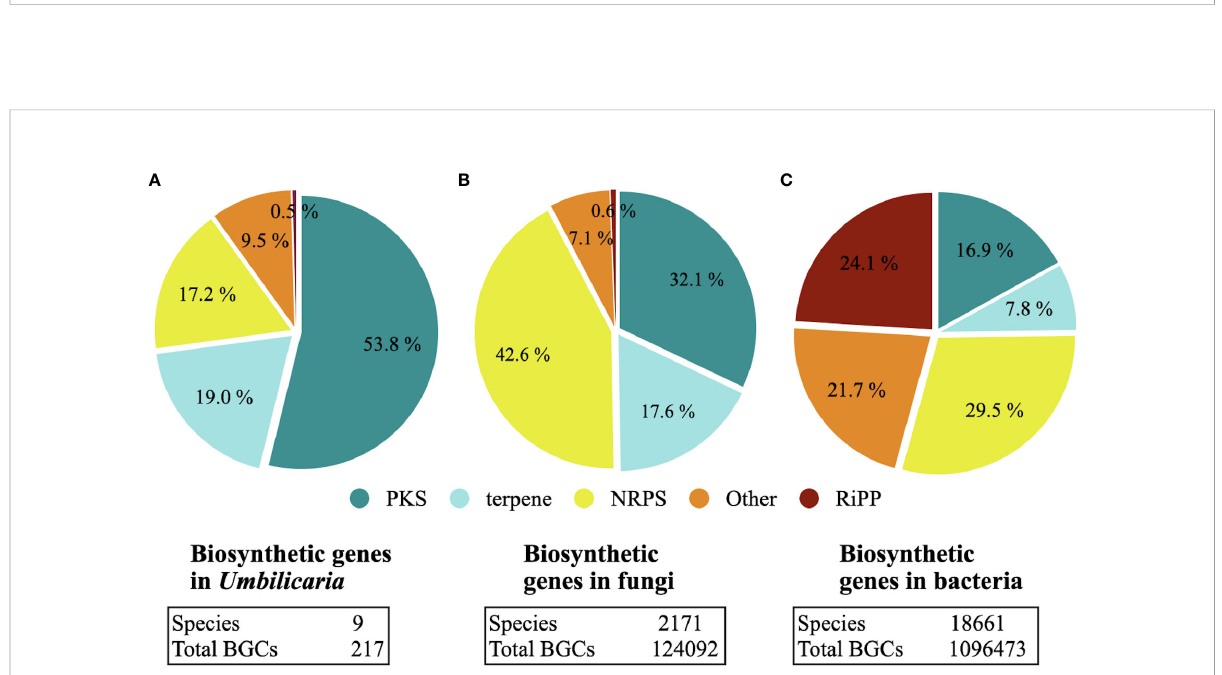
FIGURE 2 Biosynthetic gene clusters (BGCs) in (A) Umbilicaria , (B) the full fungal BGC dataset sensu Kautsar et al. 2021a, and (C) the full bacterial BGC dataset sensu Kautsar et al. 2021a. Polyketide synthases (PKSs) are the predominant class of BGCs in Umbilicaria , whereas in fungi and bacteria non-ribosomal peptide synthetases (NRPSs) are the most predominant BGC class. Although the number of publicly available lichen-forming fungal (LFF) genomes (> 50) is much smaller than the number of non-lichenized fungi (about 2,100), in all of the LFF genomes analyzed PKS clusters were the most common (see Discussion for details), suggesting that the predominance of PKSs, as observed here in the Umbilicaria dataset, is a common feature of LFF genomes.